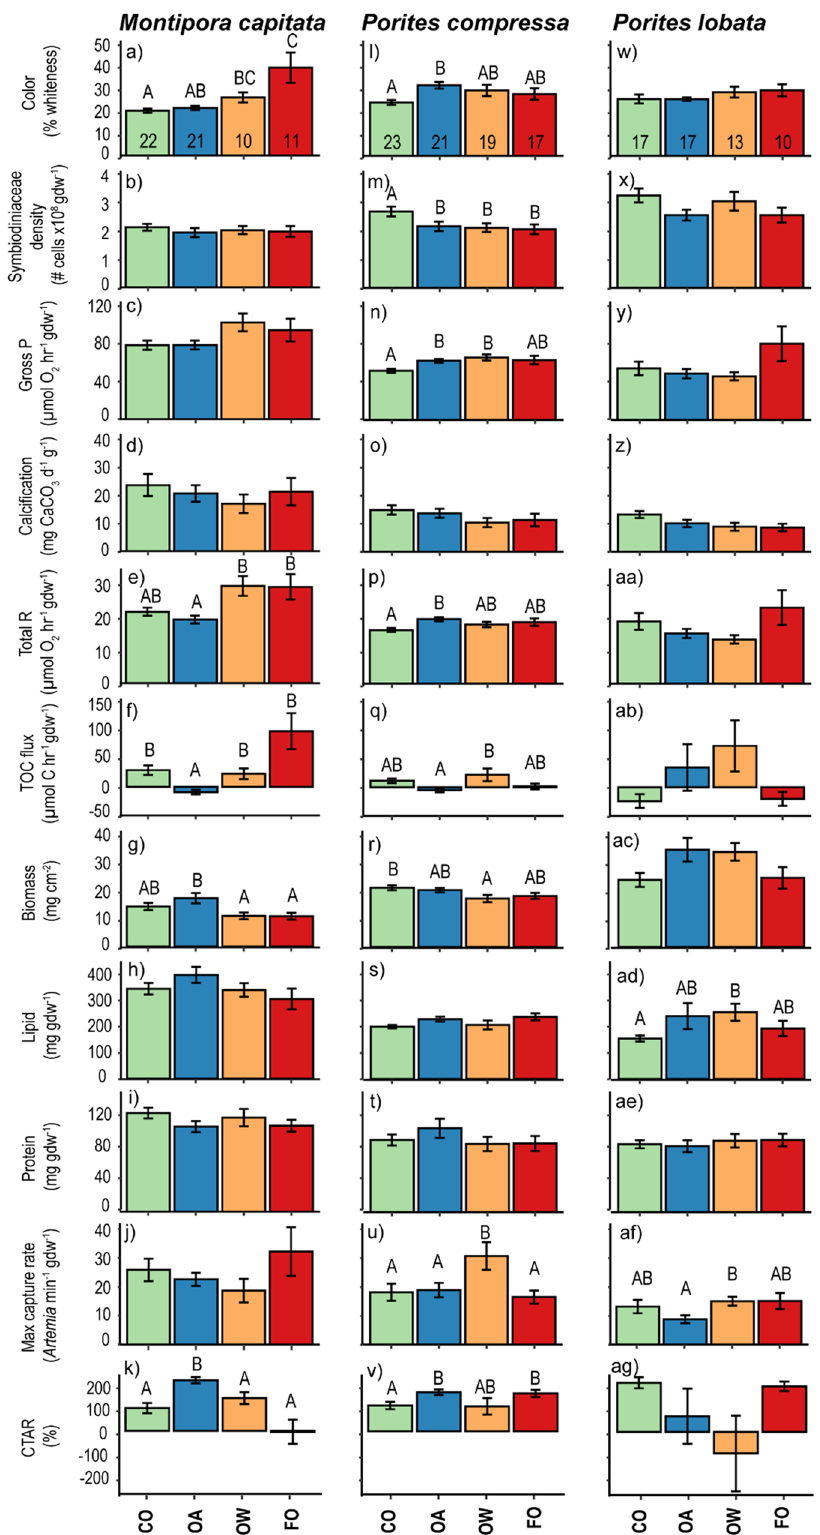
Figure 6. Mean (±1SE) of physiological traits in ( a-k ) Montipora capitata , ( l-v ) Porites compressa , and ( w-ag ) Porites lobata following 22-months exposure to control (CO, green), ocean acidification (OA, blue), ocean warming (OW, orange), or combined future ocean (FO, red) experimental treatment conditions. Uppercase letters above bars indicate the results of post-hoc tests when ANOVA was significant, whereby averages sharing letters did not significantly differ from each other. Sample sizes for each variable are shown within each bar in the top row and is the same for all panels below. Statistical details in Table S8. TOC = Total Organic Carbon Flux. CTAR = Contribution of the Total acquired fixed carbon relative to Animal